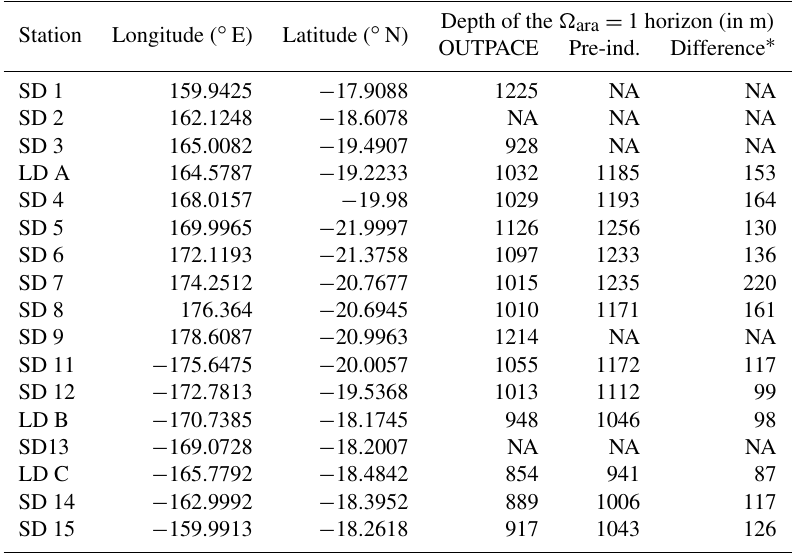
∗ Difference (in m) between the depth of the (cid:127) cruise. NA – not available.